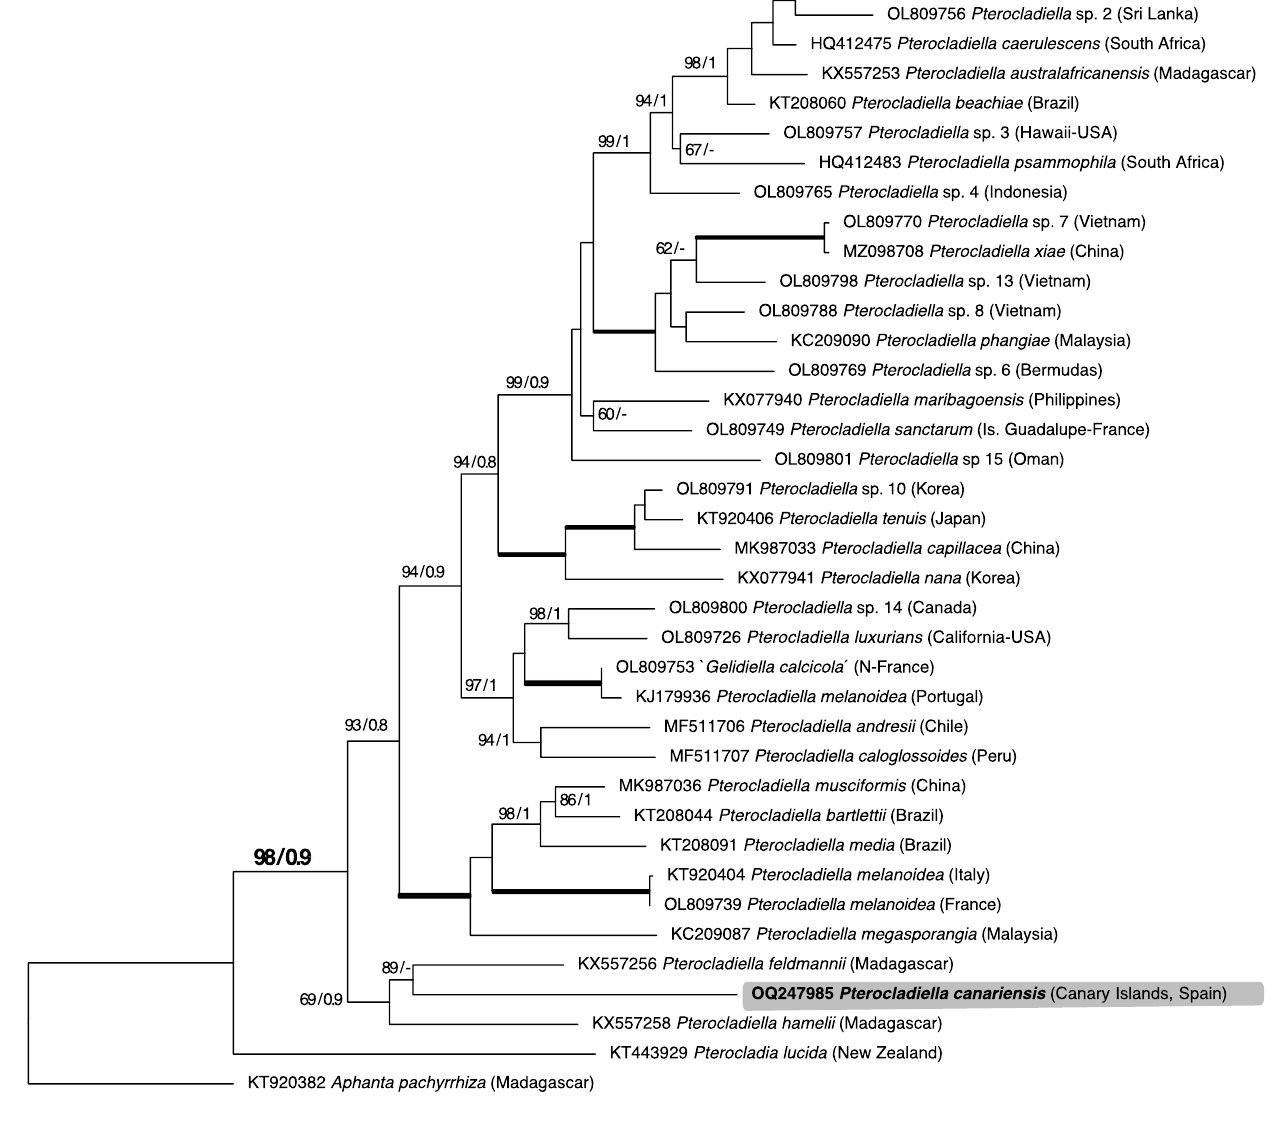
Figure 1. Maximum likelihood (ML) tree of forty-five (1397 bp) rbc L sequences calculated using the GTR+I+G evolution model. ML bootstrap values ≥60 and Bayesian inference posterior probability values ≥0.8 are shown for each branch. Black bold lines indicate full support in both analyses.